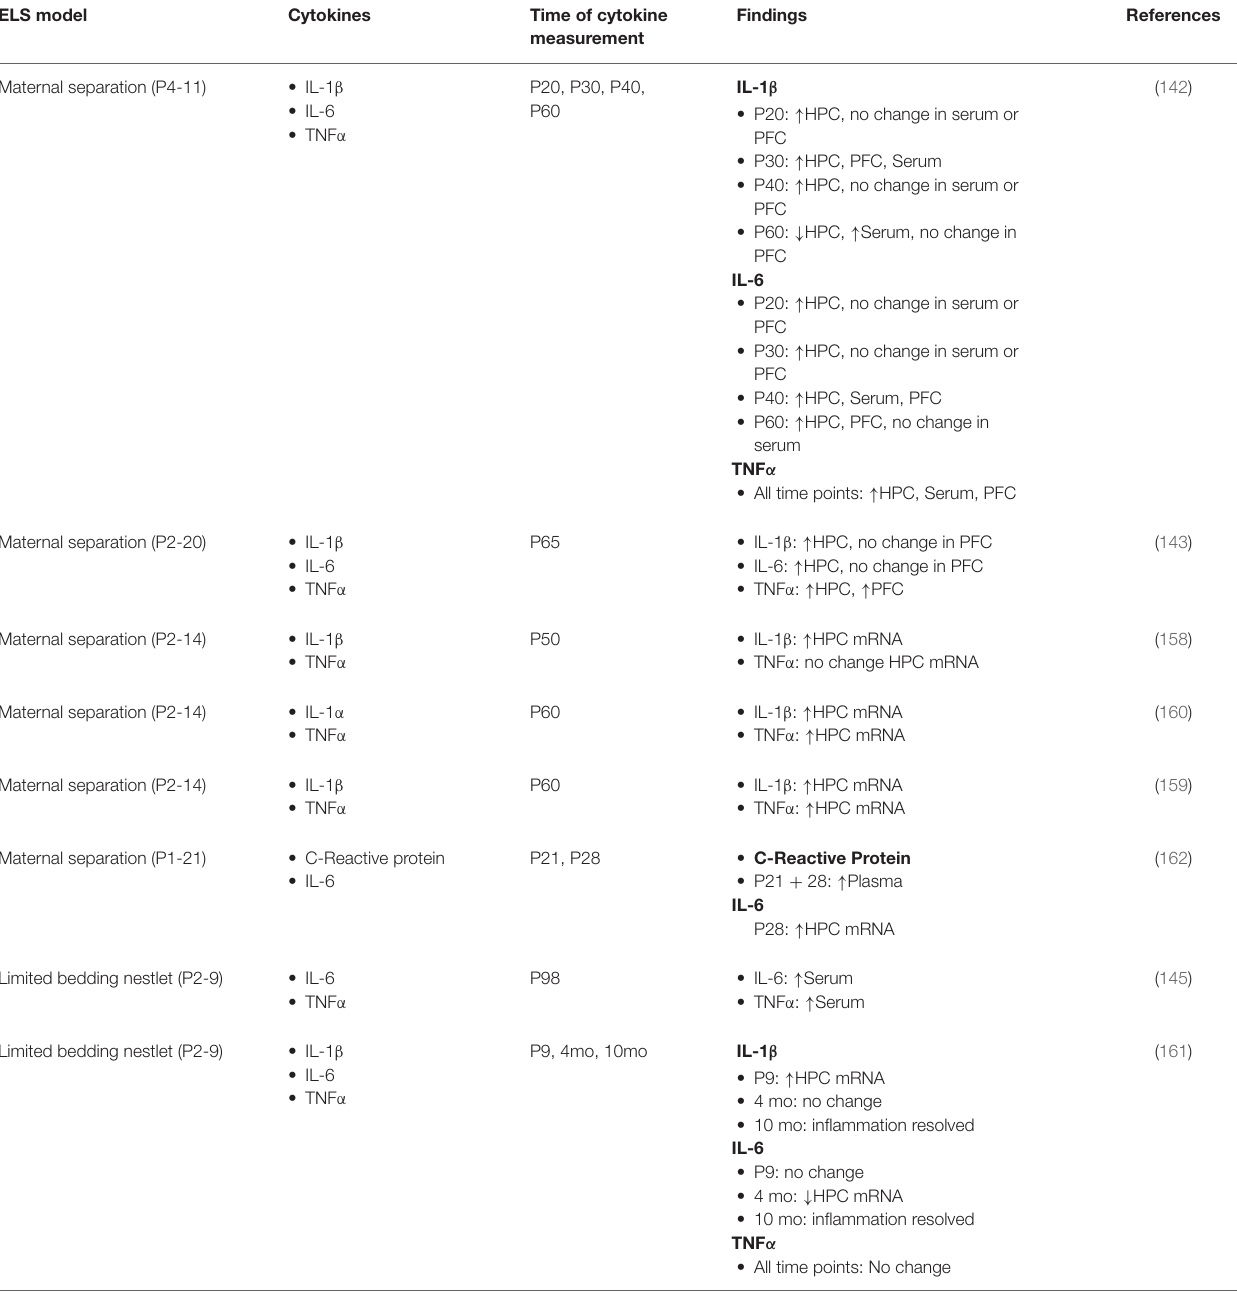
TABLE 2 | Pro-inflammatory cytokines after ELA in